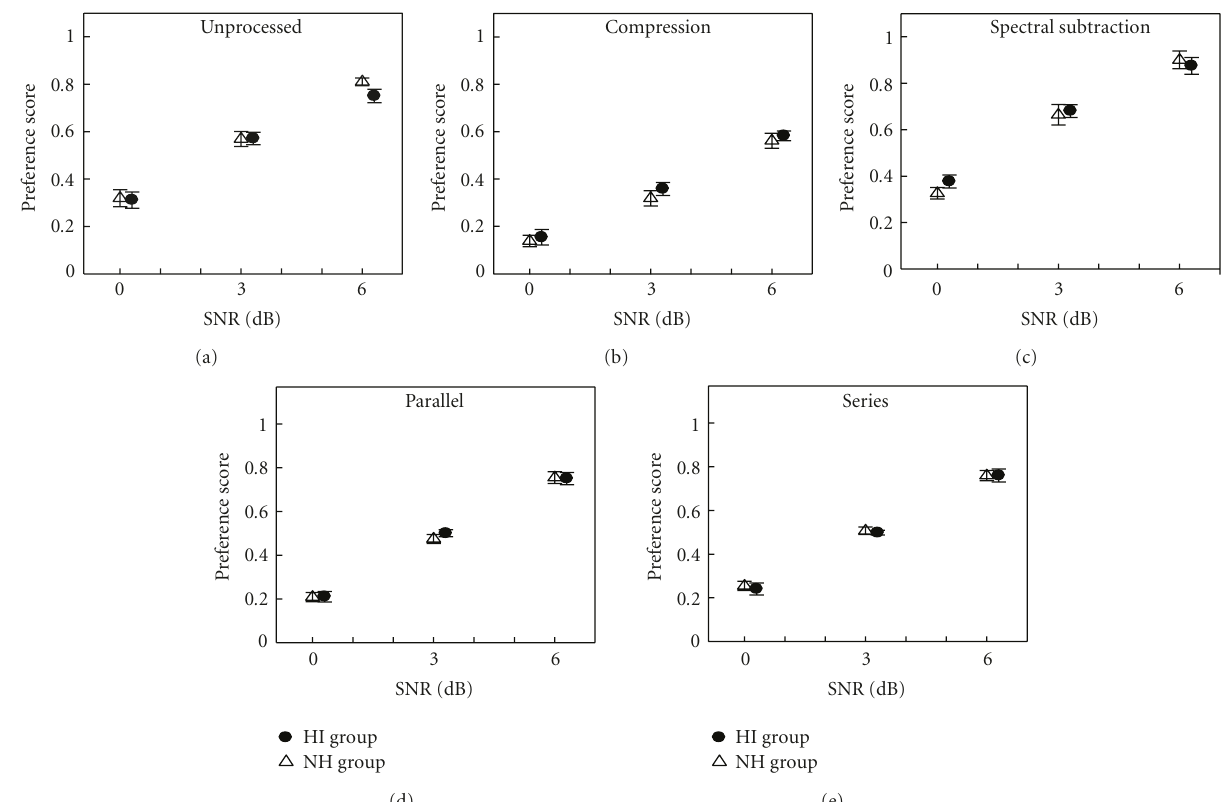
Figure 8: Subject preference scores (proportion of times a processing condition was preferred to all other processing conditions) for listeners with normal hearing (open triangles) and listeners with hearing loss (closed circles) grouped by processing condition. Error bars show the standard error of the preference scores for each group and condition. Symbols and error bars are o ff set slightly for clarity.